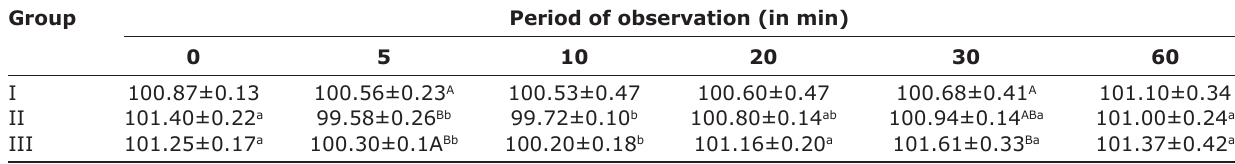
Table-1: Mean±SE value of rectal temperature (°F) of different groups at different time intervals of observation. Group Period of observation (in min)